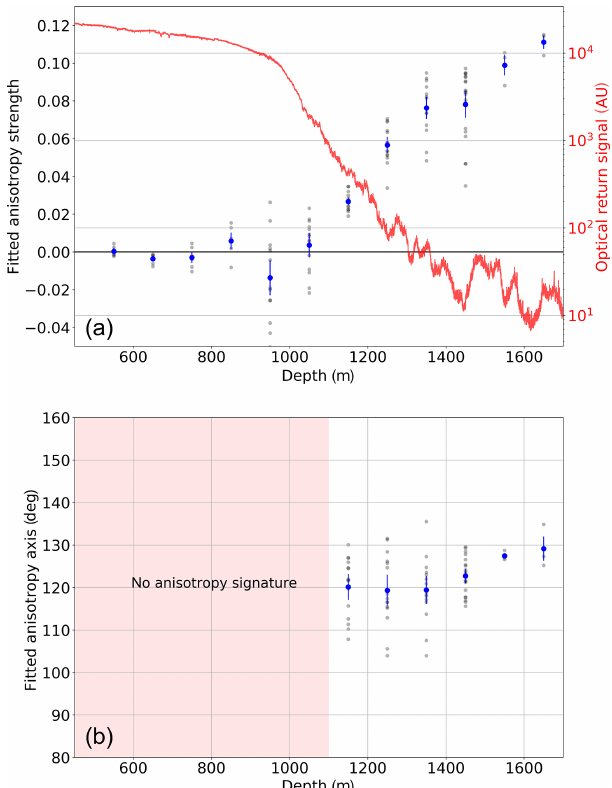
Figure 7. Depth-dependence of fitted quantities. Gray dots denote values obtained from individual ratios. The blue markers indicate the average at each depth. (a) Anisotropy strength. An example log is superimposed as reference. (b) Anisotropy axis with respect to lo- cal grid bearings. Grid north (0 ◦ ) aligns with the Greenwich merid-